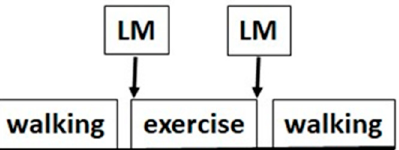
Figure 1. Experimental protocol. Note: LM: blood lactate measurement.